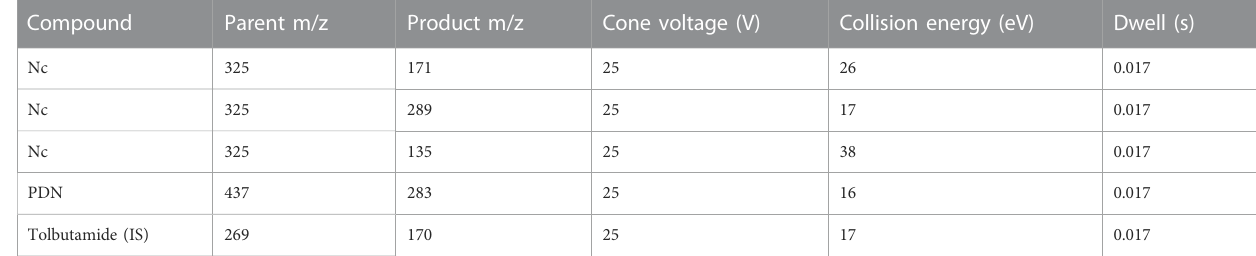
TABLE 1 MRM transitions monitored for the analysis of Nc and PDN in biological samples. Compound